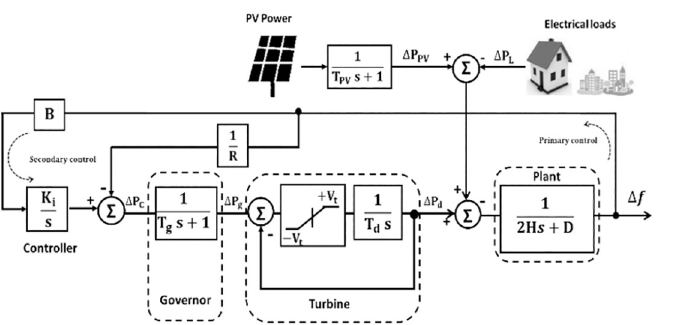
Fig 1. Islanded single area μ G model without the